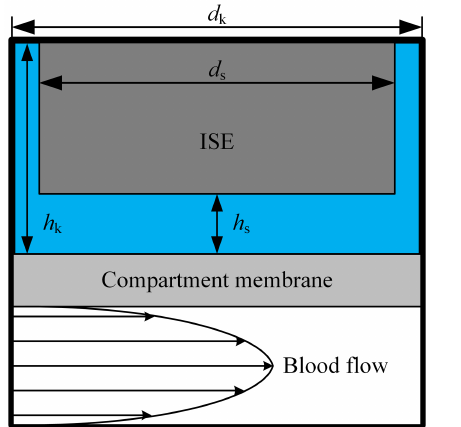
Figure 2. Schematic of the used simulation model with a laminar blood flow in the extracorporeal circuit. The liquid-filled ISE com- partment has a diameter d k of 12.1mm and a height h k of 5mm. The diameter d s of the ISE is 12mm; h s describes the variable dis- tance between compartment membrane and the sensitive layer of the